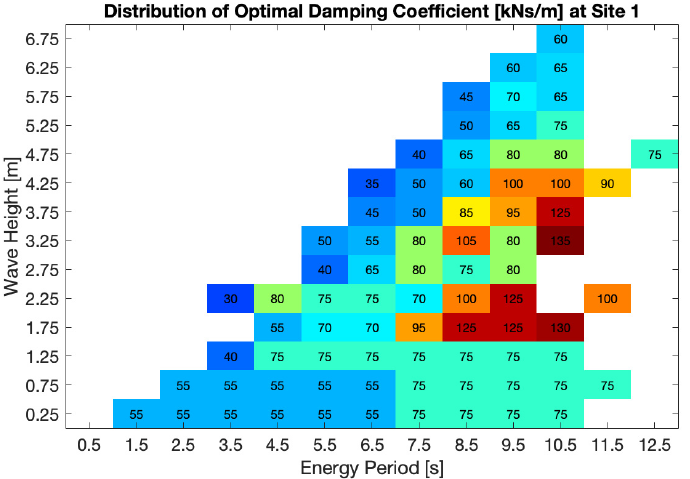
Figure 11. Scatter diagram displaying the distribution of optimal damping coefficients corresponding to the sea state from Site 1.